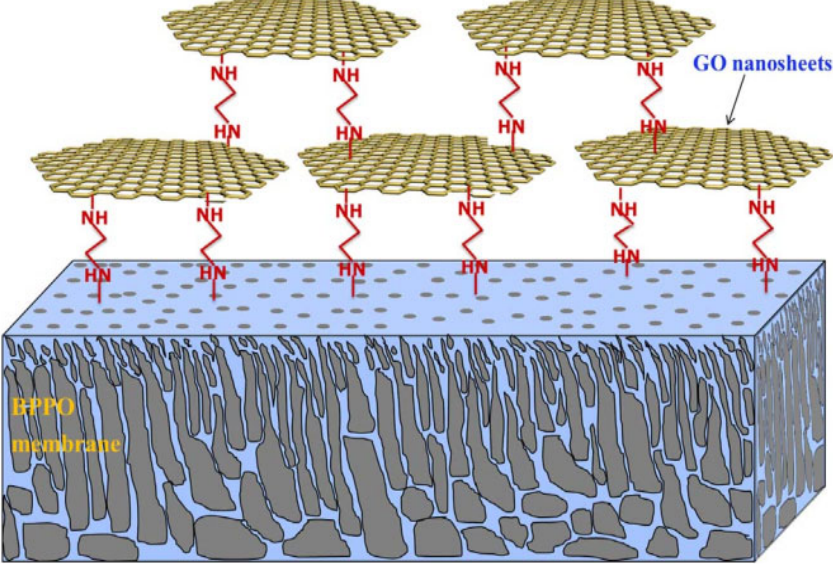
Figure 4. Illustration of low-pressure NF membrane embedded with EDA-functionalized GO [66]. (Copyright 2018. Reproduced with permission from Elsevier.)